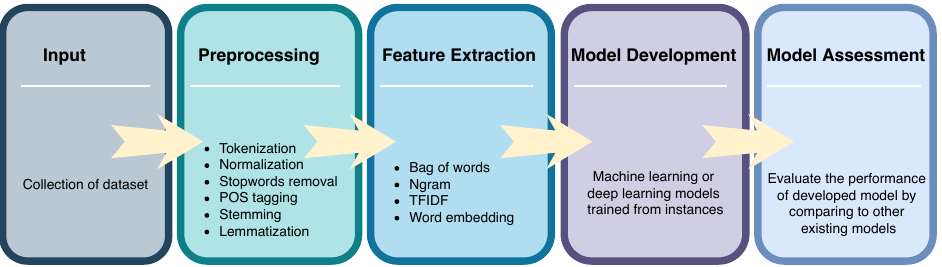
Figure 2. Block diagram for the proposed